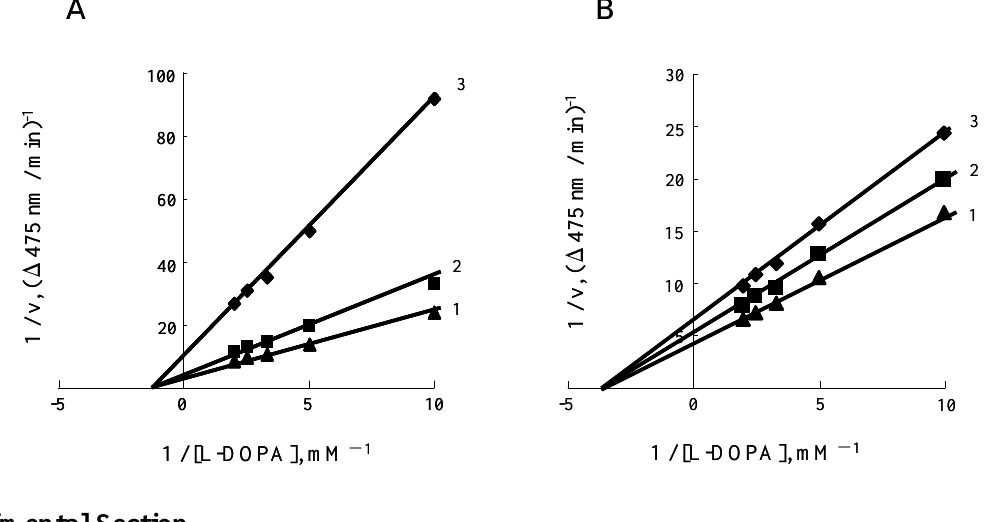
Figure 8. Determination of inhibitory type of diflunisal and indomethacin on diphenolase activity of mushroom tyrosinase. ( A ) Lineweaver-Burk plots for inhibition of diflunisal on diphenolase activity. The concentrations of diflunisal for curves 1–3 were 0.1, 0.2 and 1.0 mM, respectively; ( B ) Lineweaver-Burk plots for inhibition of indomethacin on diphenolase activity. The concentration of indomethacin for curves 1–3 were 0.1, 0.2 and